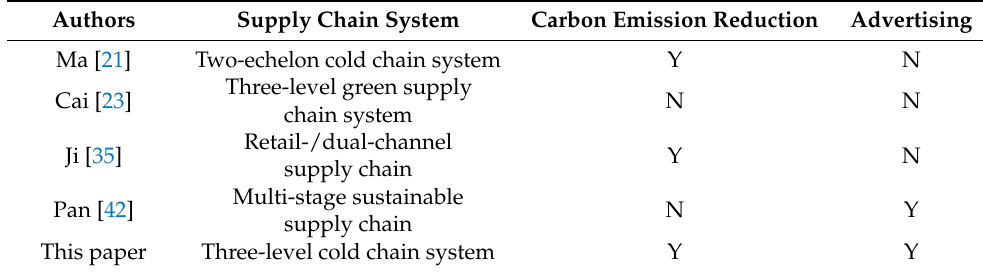
Table 1. Summary of the scenarios in the related